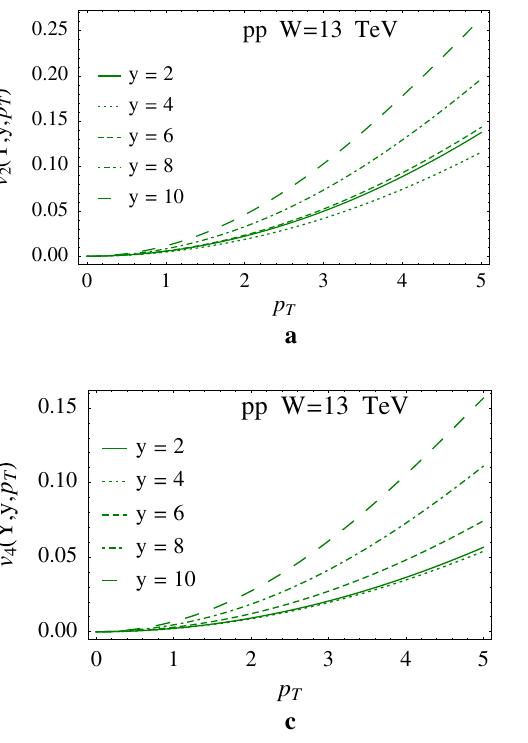
Fig. 5 v n versus p T ( a , c ) and versus y ( b , d ) at W = 13 TeV